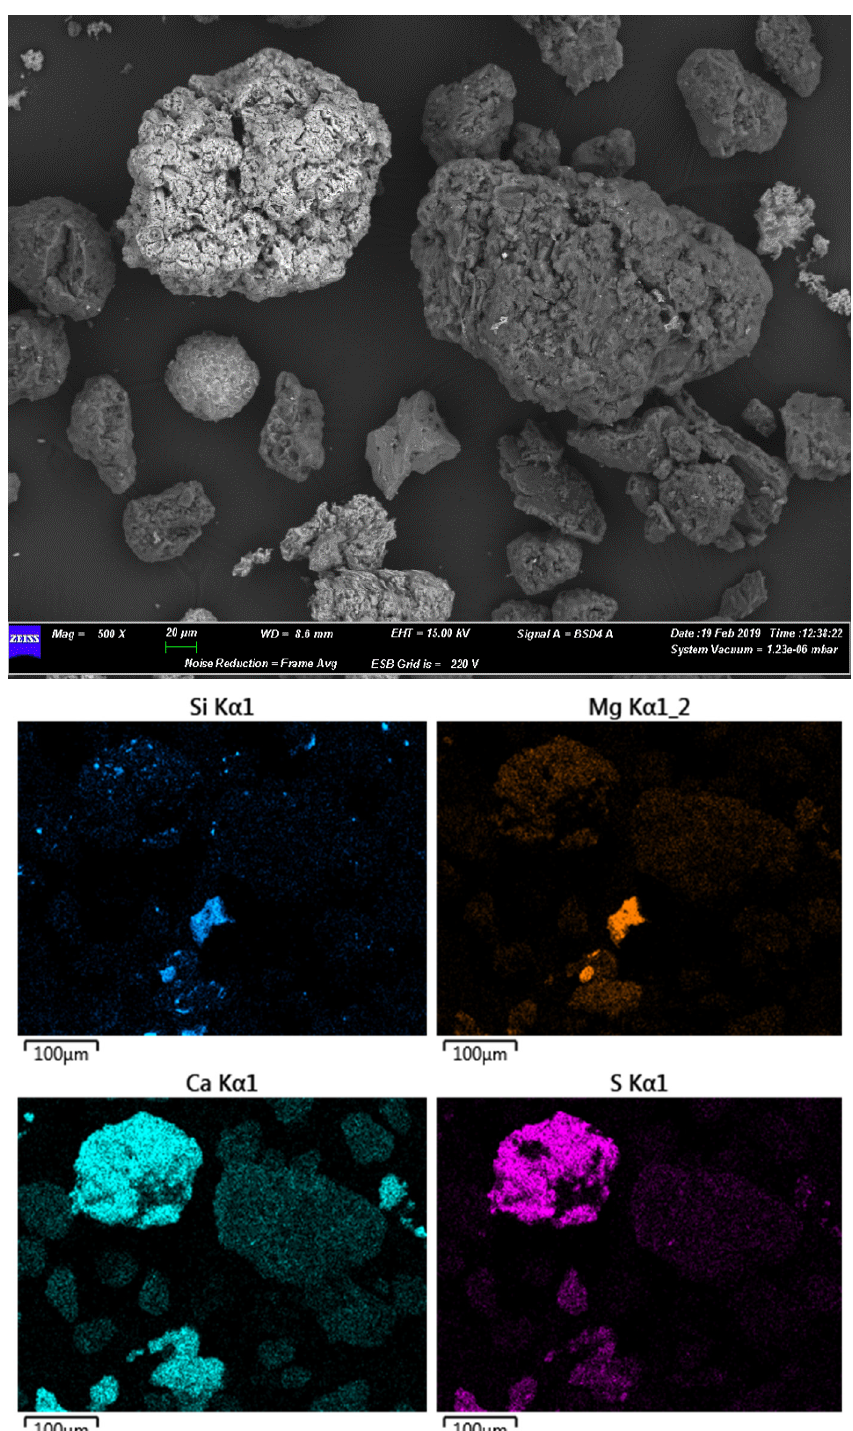
Figure 4. SEM / EDS of ash from lignite (image Figure 4. SEM/EDS of ash from lignite (image 1) .